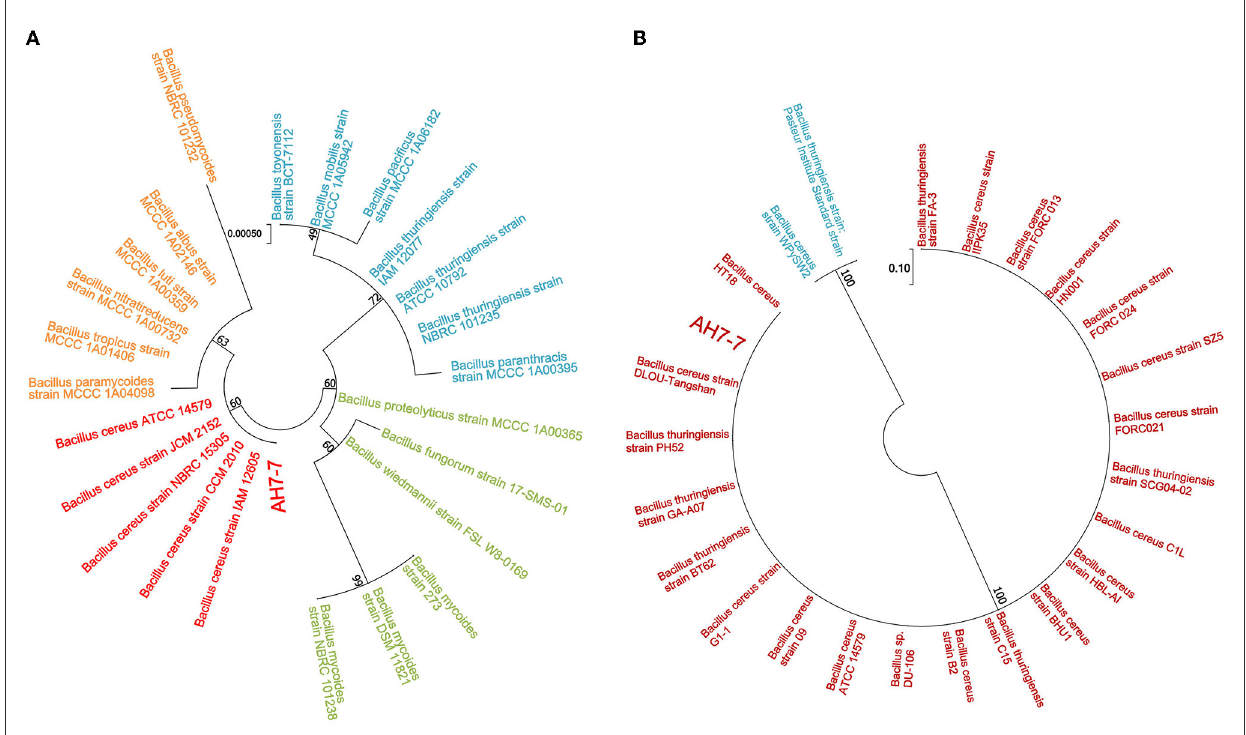
FIGURE2 Phylogenetic tree of strain AH7-7. (A) 16S rRNA and (B)